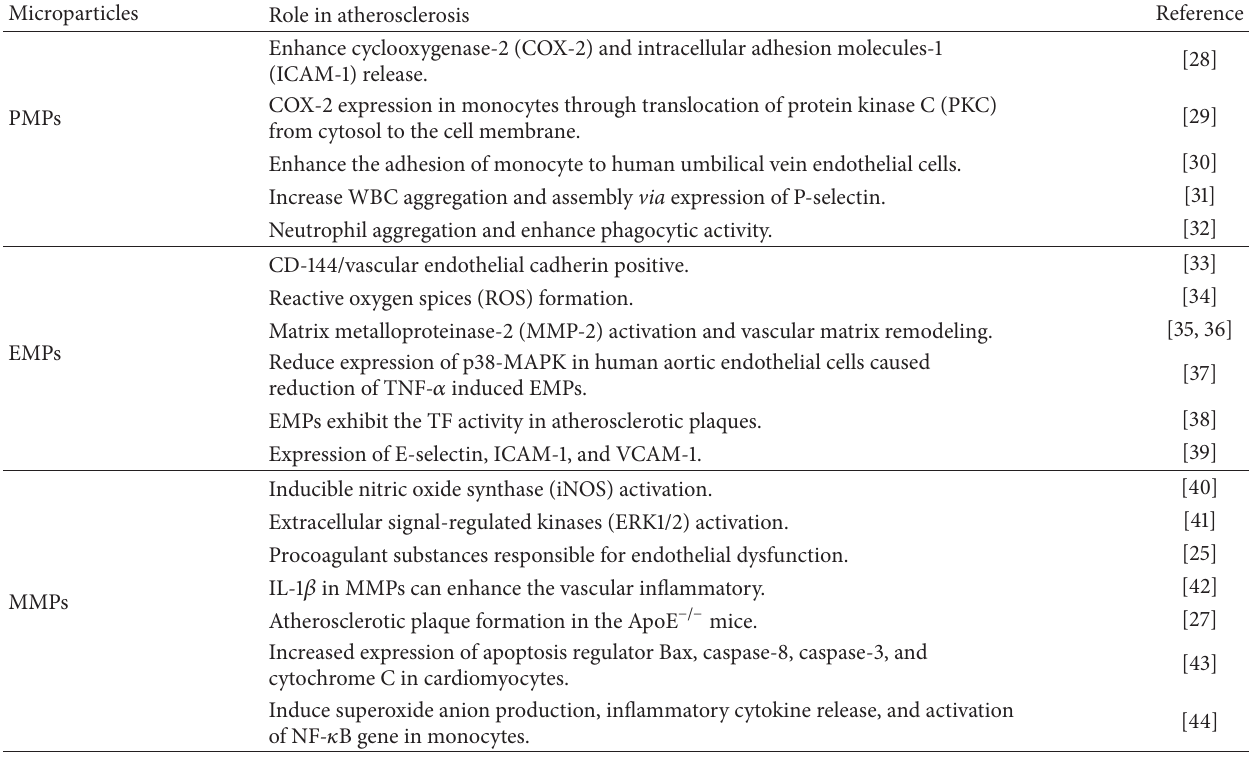
Table 2: Scientific work on microparticle in association with its link with atherosclerosis.